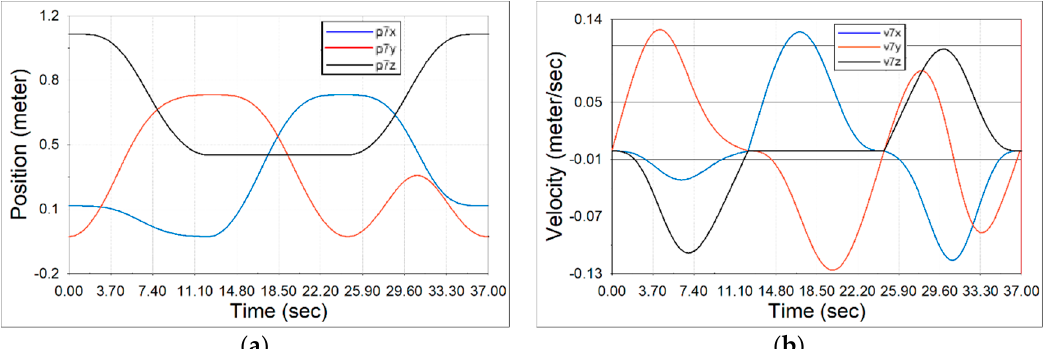
Figure 13. Effector values generated in SolidWorks: ( a ) position vector p 7 = [ p 7x , p 7y , p 7z ] T depending on the joints coordinate vector φ (t) ; ( b ) velocity vector v 7 = [ v 7x , v 7y , v 7z ] T depending on the joints coordinate vector φ ′ (t).